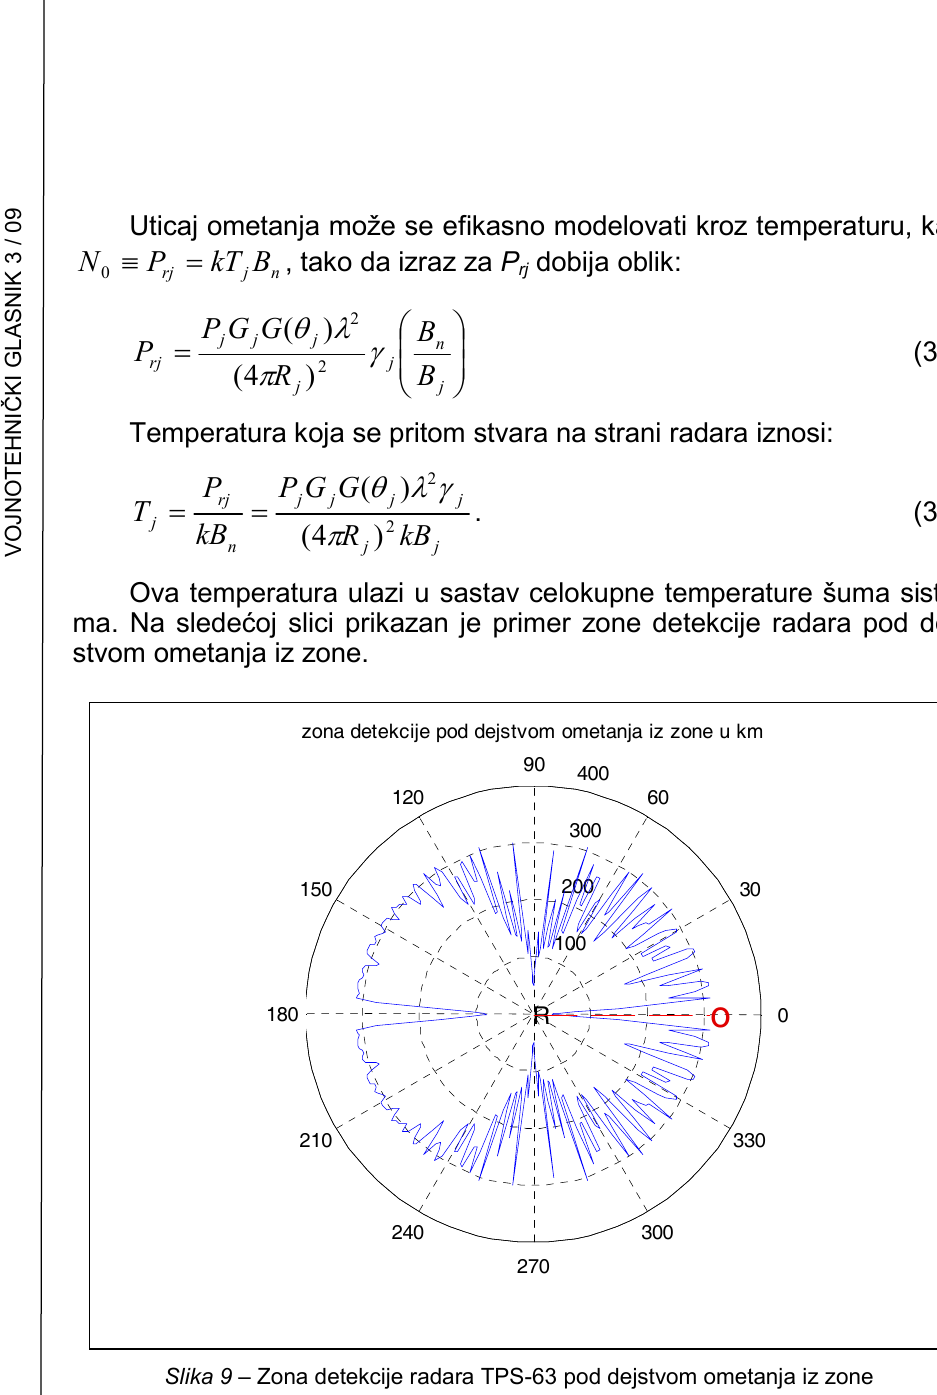
tekcije radara. Vidi se da je najve ć i efekat dejstva ispoljen na glavnom lo- bu zbog najve ć eg dobitka antene na tom pravcu. Efekat je izražen i